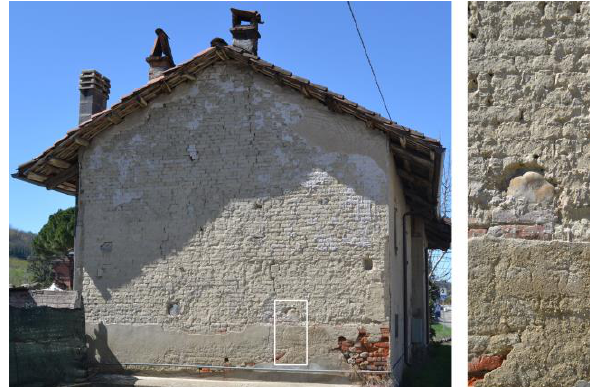
Figure 2. Earth plasters on adobe walls, Photo by the